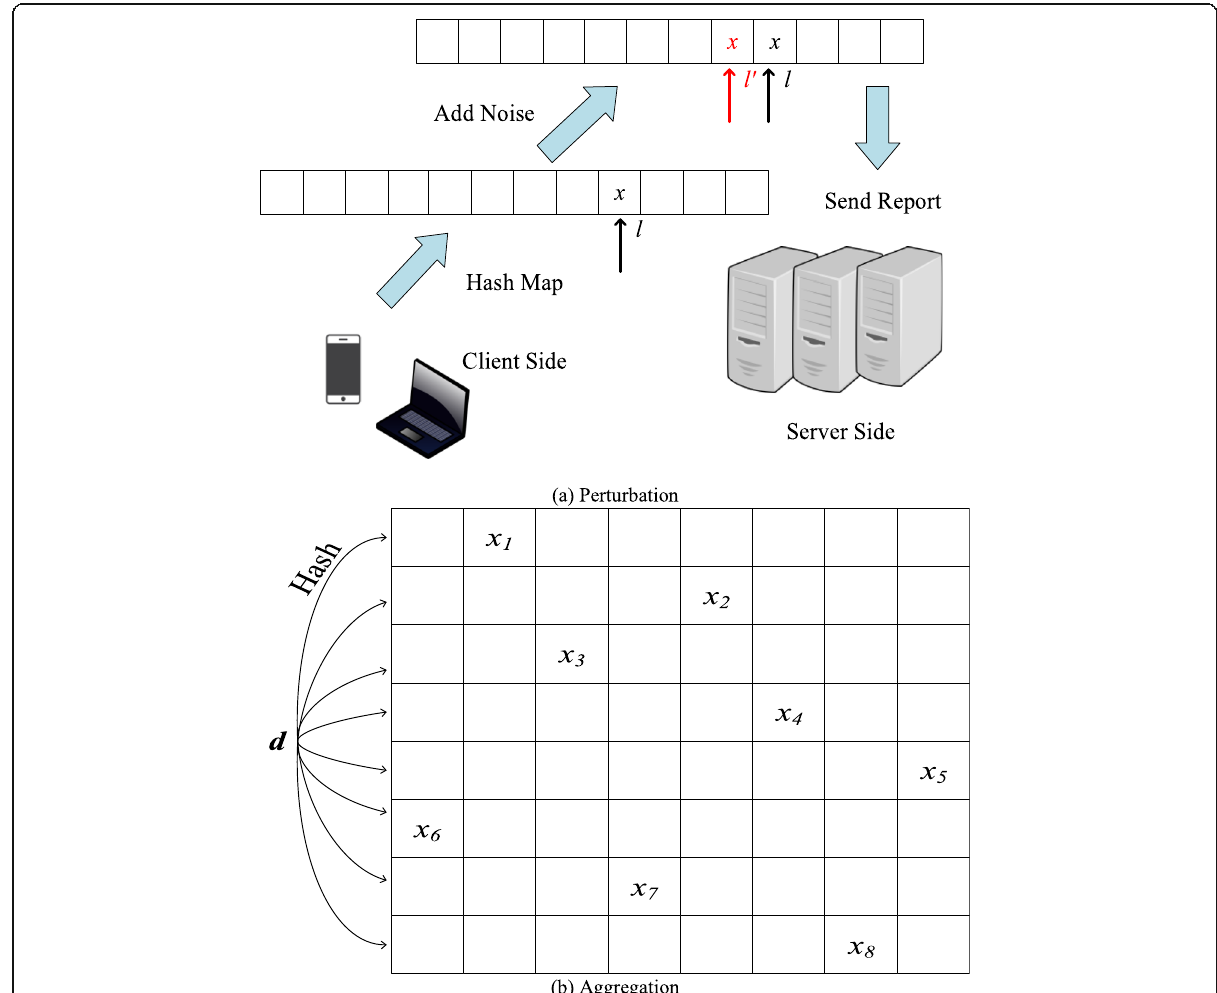
Fig. 2 The algorithm system structure. a Perturbation. b